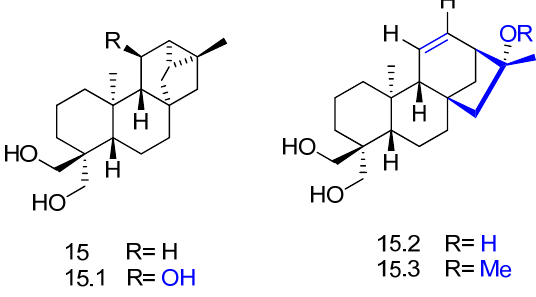
Figure 16. Chemical structures of 15 and its derivatives 15.1 , 15.2 and 15.3 obtained by biotransformation with Rhizopus stolonifer [64] .